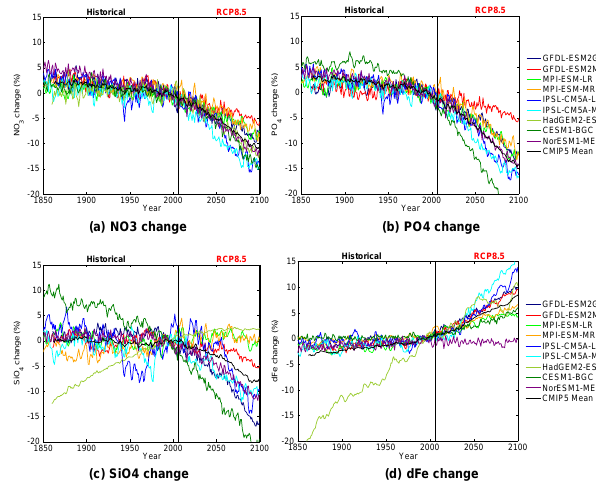
Figure 4. Time series are displayed of mean changes (in percent) relative to the 1990s for (a) NO 3 , (b) PO 4 , (c) SiO 4 and (d) dFe (0–100m) during